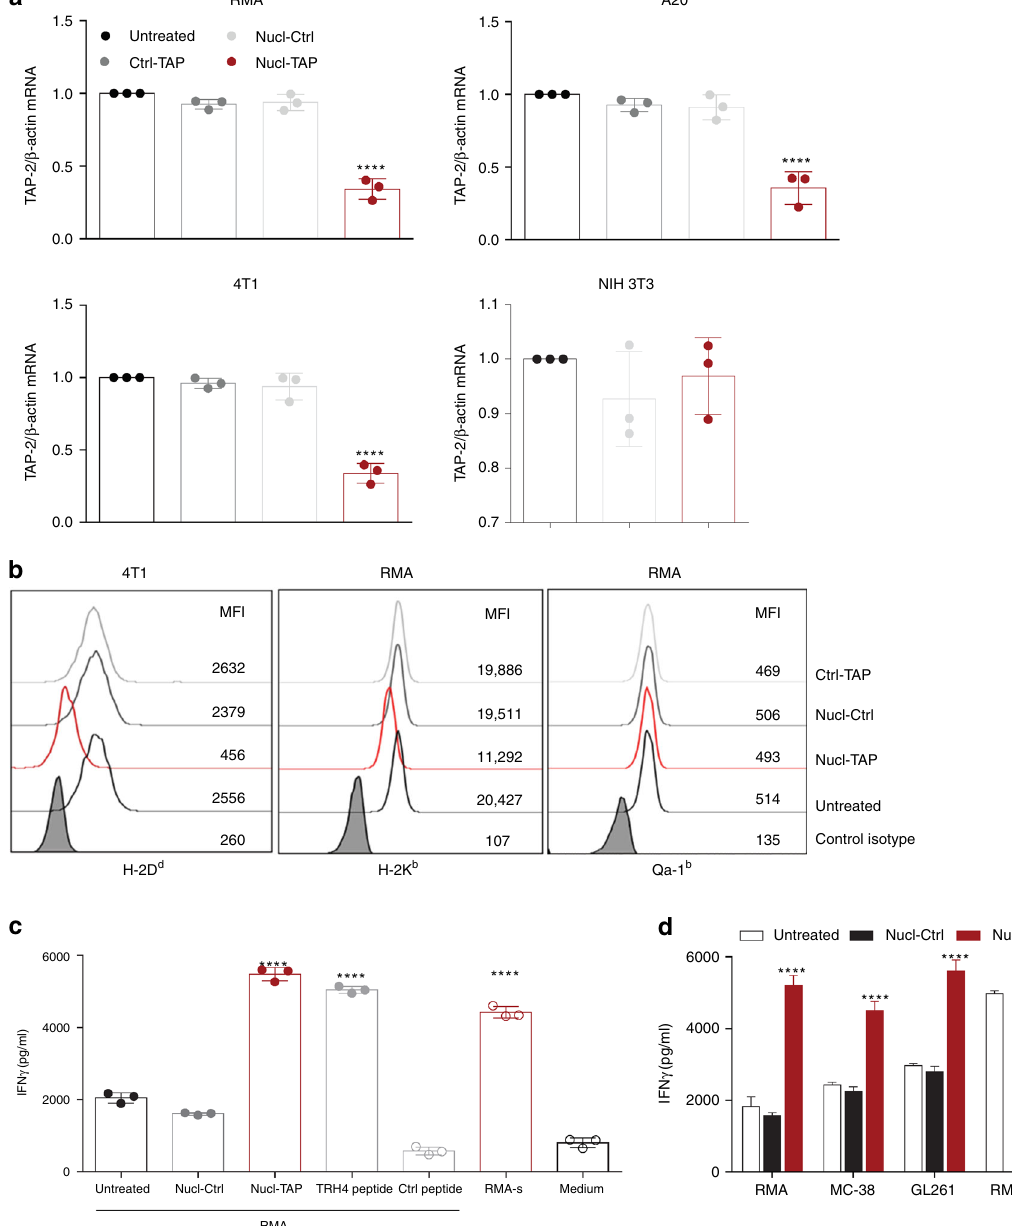
Fig. 1 Nucleolin aptamer-targeted delivery of TAP siRNA in vitro. a Downregulation of TAP RNA in tumor, but not NIH 3T3, cells incubated with Nucl-TAP. Cells were treated with aptamer-siRNAs and 24 h later RNA was isolated and quanti fi ed by qRT-PCR. Data represent means and SEM performed in triplicates ( n = 3). b Downregulation of MHC class Ia but not Ib alleles analyzed by fl ow cytometry in cells as described in panel a after 48 h ( n = 3). c and d Presentation of the TRH4 peptide. Cells were treated with Nucl-siRNAs or pulsed with peptides and cultured with LnB5 T cells. INF γ production after 20 h stimulation was measured by ELISA. Means and SEM of triplicate wells are represented ( n = 3). Statistical analyses using one-way ANOVA test and Dunnet posttest for comparison between untreated and treated cells. Differences are indicated: **** P <